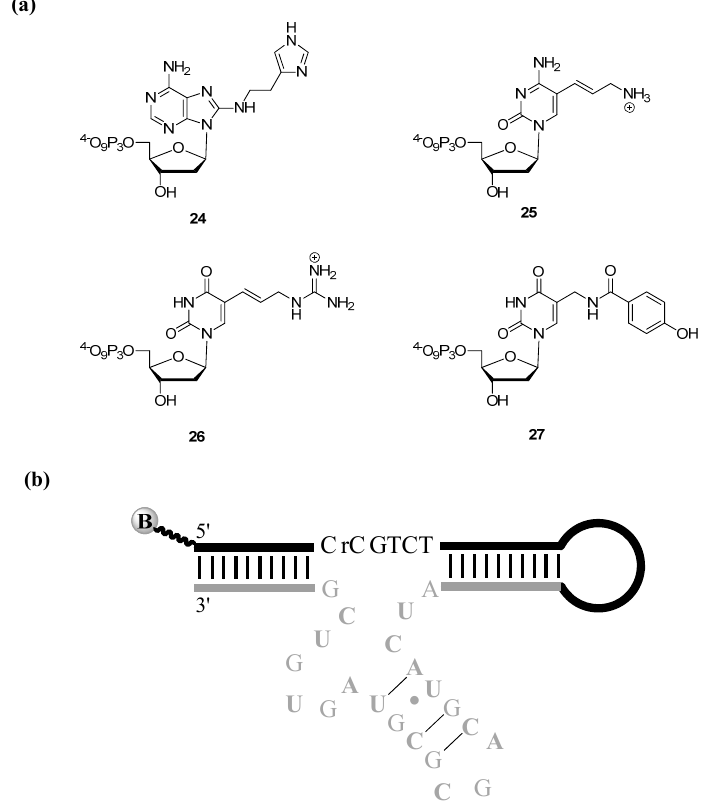
Figure 5. ( a ) Chemical structures of dA im TP 24 , dC aa TP 25 , dU ga TP 26 , and the phenol-modified dUTP 27 ; ( b ) Sequence and hypothetical 2D structure of Dz9-86 (bold-face A’s, U’s, and C’s indicate the position of the modified nucleosides)